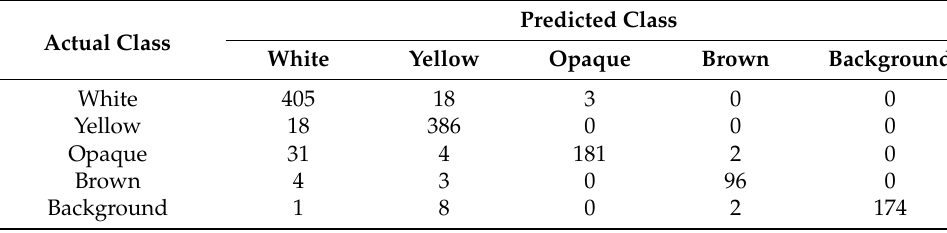
Table 4. Confusion matrix of pixel-wise classification based on multiple